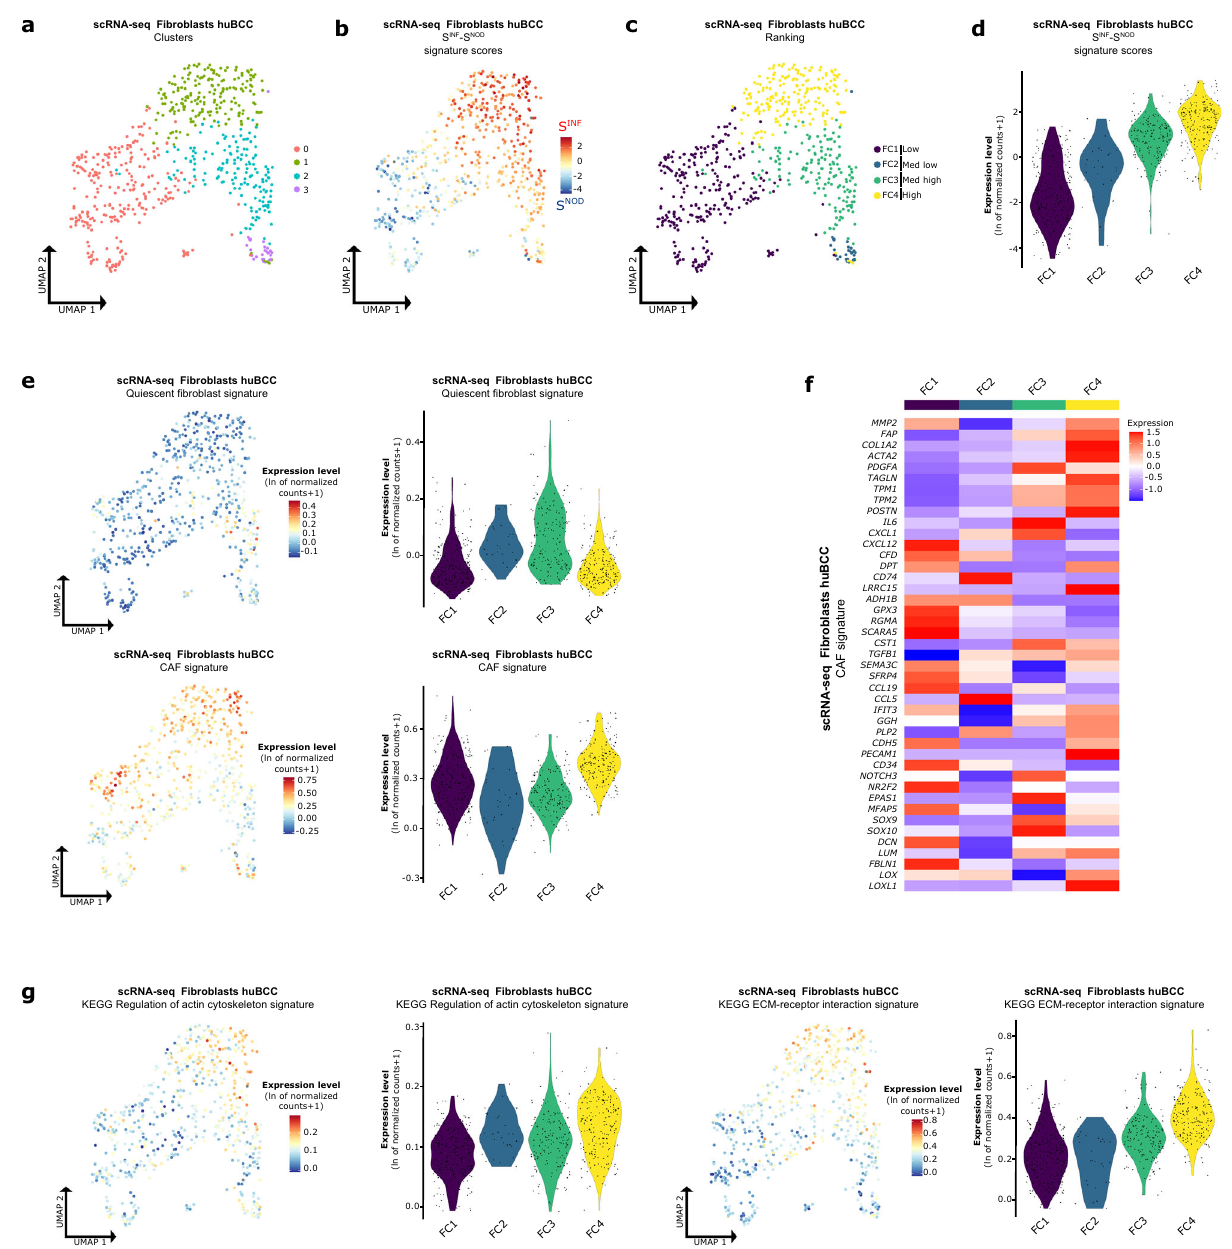
Fig. 5 | CAFs found within the invasive niche harbor ECM-remodeling features. a Unsupervisedclustering of the fi broblast subpopulations representedas aUMAP plot. b Average expression level of the difference between spatial S INF and spatial S NOD signature scores in fi broblast subpopulations of the scRNA-seq dataset, represented as a color scale overlaid on the UMAP plot. c UMAP illustrating the unsupervised clusters ranked according to their mean difference between the spatial S INF and spatial S NOD signature scores in fi broblast subpopulations of the scRNA-seqdataset. d Averageexpressionlevelofthedifferencebetweenthespatial S INF and spatialS NOD signaturescoresin fi broblastsubpopulations of the scRNA-seq dataset,representedasviolinplotsperrankedcluster. e Averageexpressionlevelof the “ Quiescent fi broblast ” and “ CAF ” signatures in fi broblastsubpopulationsof the